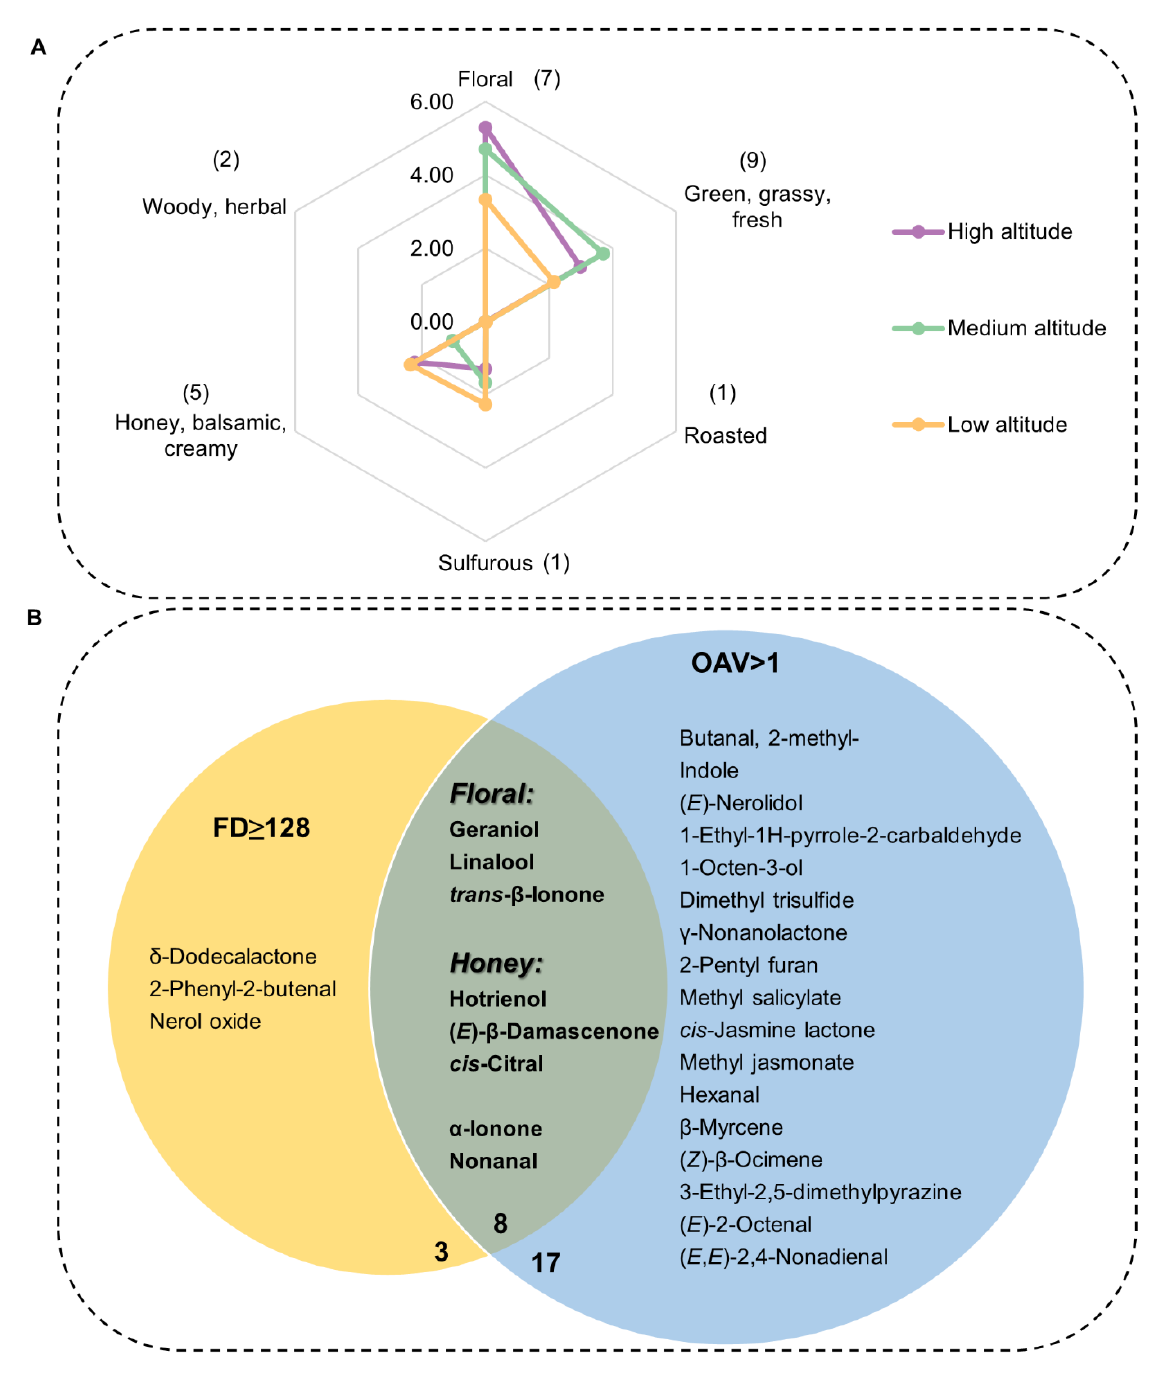
Figure 4. Aroma profile and key contributors of Lingtou Dancong oolong tea. ( A ) Specific scores were obtained by conversion according to OAV, and the numbers in brackets indicated the number of compounds; ( B ) Most important aroma contributors in Lingtou Dancong oolong tea identified according to FD and OAV. FD, flavor dilution factor; OAV, odor activity value. The number bellowed the circle indicates the number of compounds. High altitude, medium altitude and low altitude represent the Lingtou Dancong oolong teas from high, medium and low altitude, respectively.